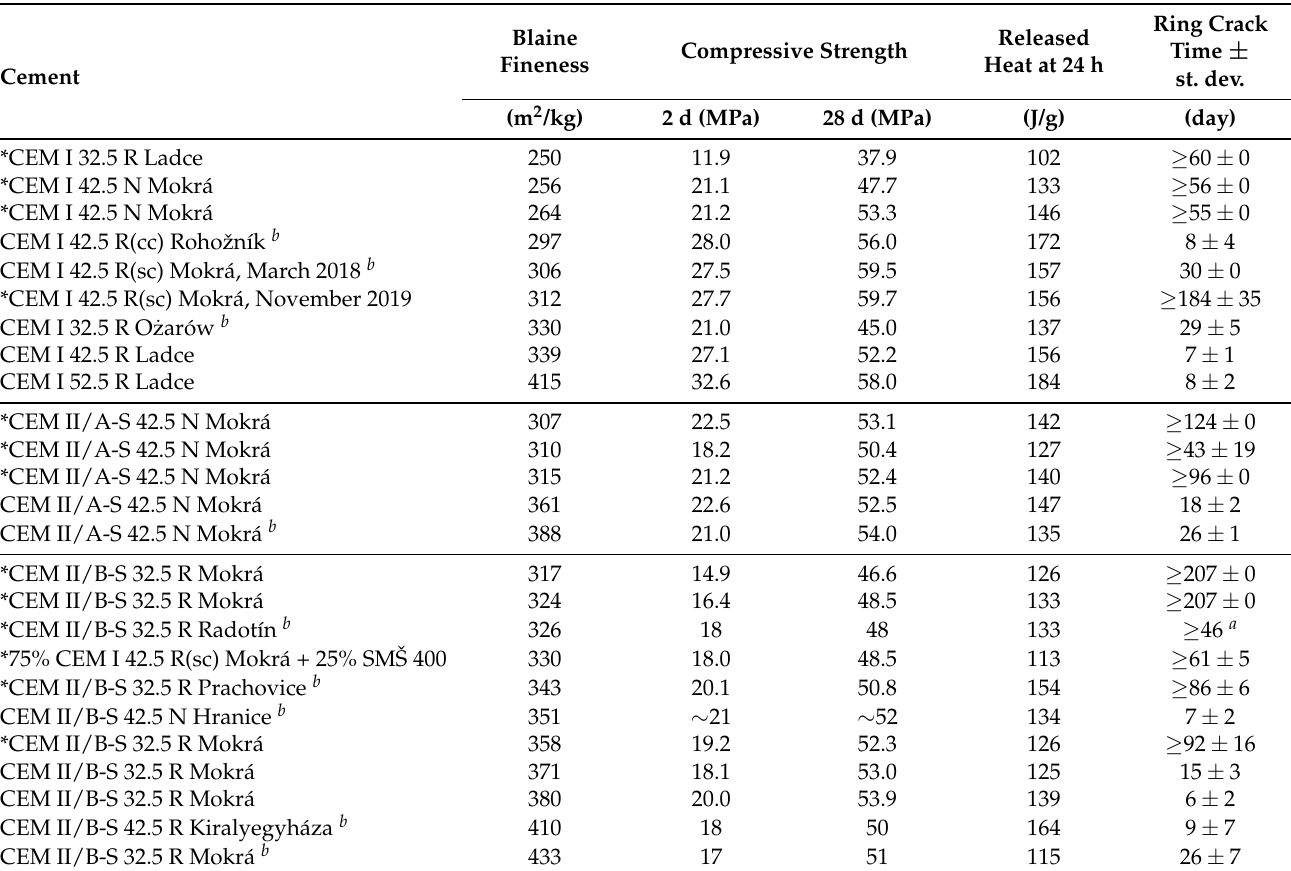
Table 2. Relevant properties of tested cements sorted according to the Blaine fineness and cement